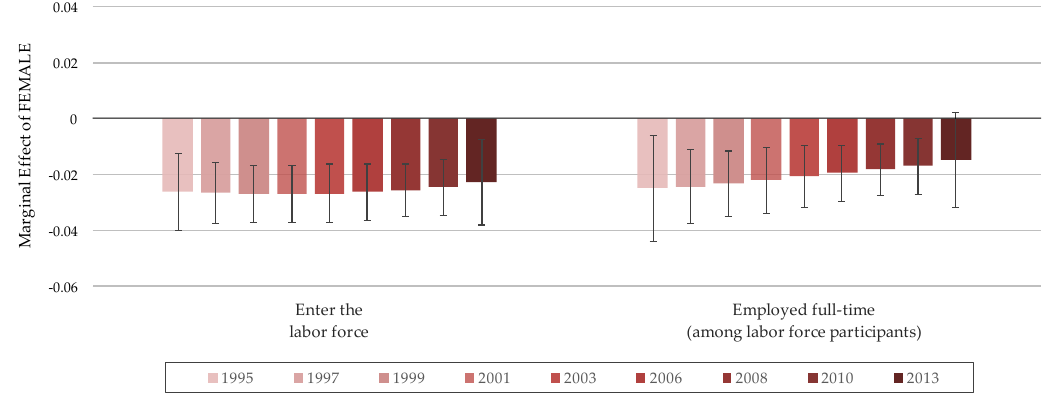
Figure 4. Estimated marginal effects of FEMALE on the likelihood of labor force participation and full-time employment (among those in the labor force), for all STEM doctorates by year. Source : Author’s calculations using data from the Survey of Doctorate Recipients [22] and the O*NET Occupational Information Network Database [23], 1995–2013.